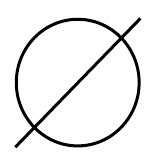
Figure 2.14: The source and sink